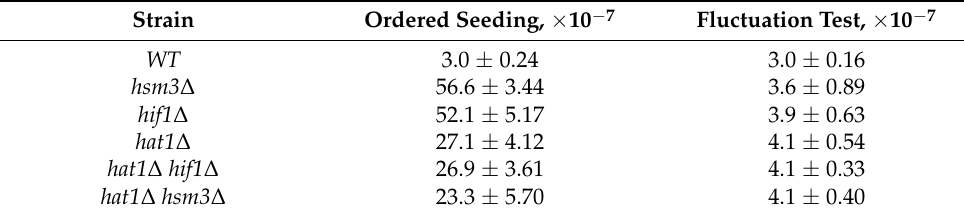
Table 3. Spontaneous mutagenesis of resistance to